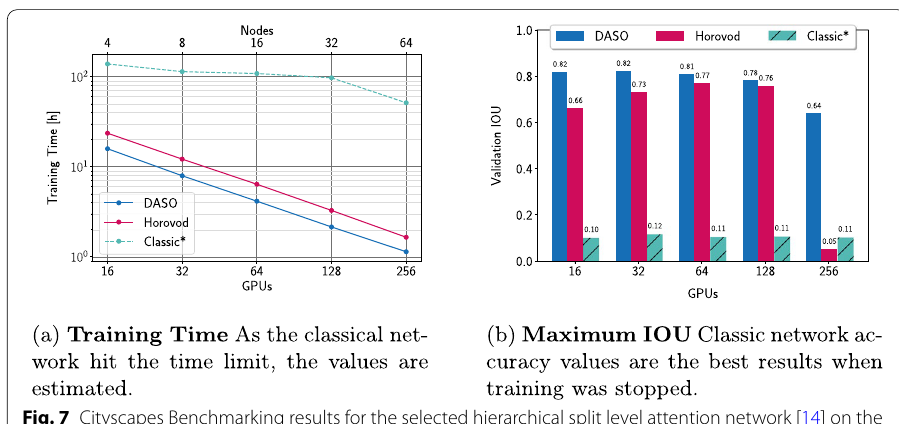
Fig. 7 Cityscapes Benchmarking results for the selected hierarchical split level attention network [14] on the Cityscapes dataset with DASO, Horovod, and the classic DPNN method for increasing node counts, each with four